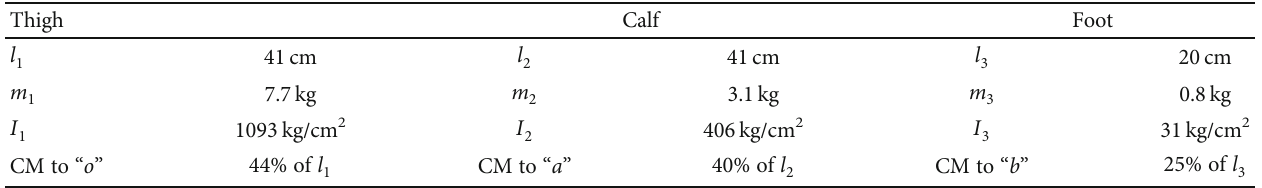
Table 1: Physical parameters of the human legs